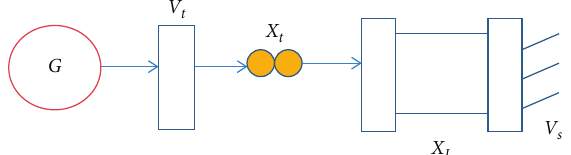
Figure 1: Schematic diagram of the single machine infinite bus system.